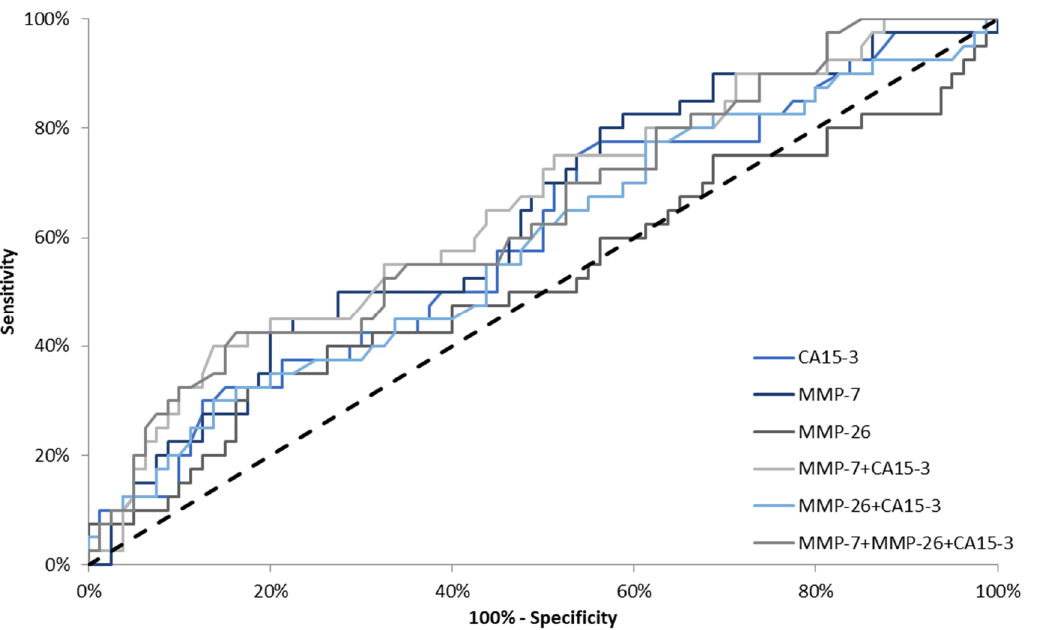
Figure 4. Diagnostic criteria of ROC curve in stage I breast cancer (BC). CA 15-3—cancer antigen 15-3; MMP-7—matrilysin-1; MMP-26—matrilysin-2.